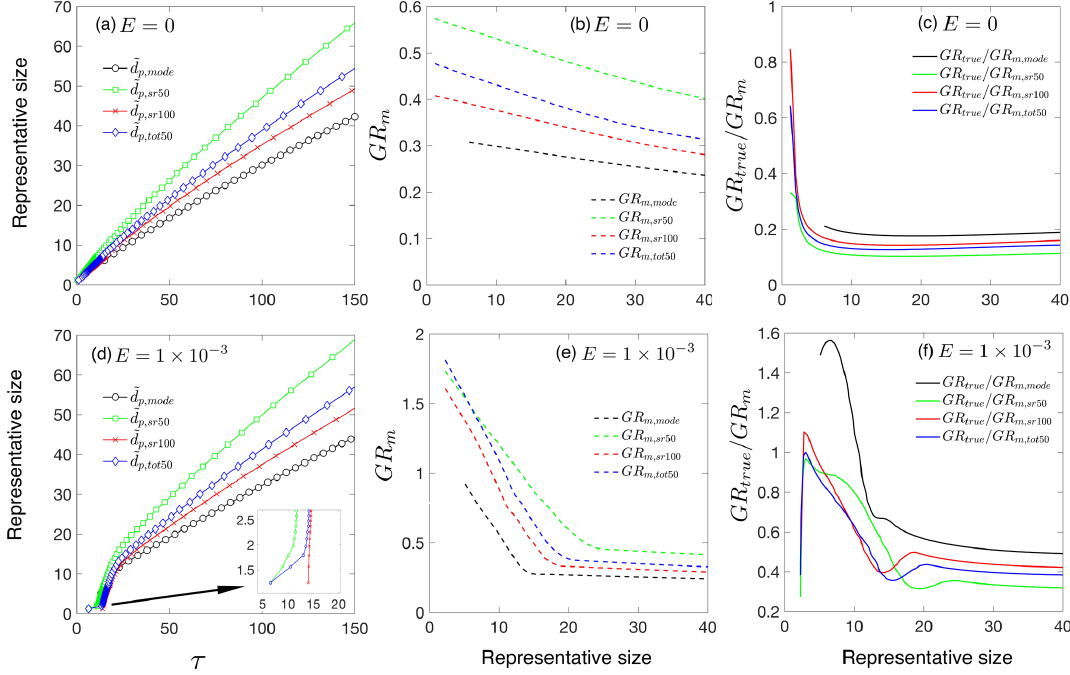
Figure 3. (a) e d p , mode , e d p , sr100 , e d p , tot50 and e d p , bin50 as functions of time. (b) Measured growth rates GR m , mode , GR m , sr50 , GR m , sr100 and GR m , tot50 as functions of representative sizes. (c) Ratio of true growth rate to measured growth rate, GR true / GR m . Panels (a) – (c) are for collision-controlled nucleation with E = 0. Panels (d) – (f) show the same quantities as are shown in panels (a) – (c) but with E = 1 × 10 − 3